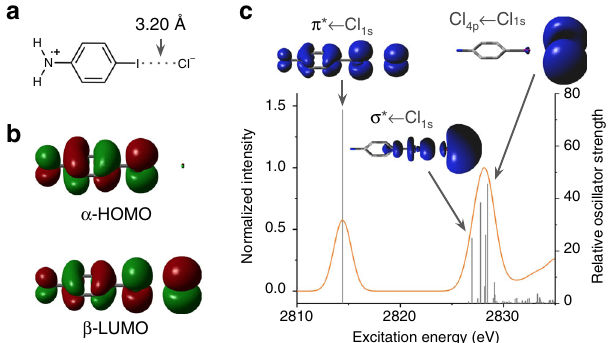
Fig. 5 Simulated [p-iodoaniline] (cid:129) + ···Cl – model system. a The halogen bonding adduct structure of [p-iodoaniline] (cid:129) + ···Cl – . b The α - and β -spin single-electron orbital components of the [p-iodoaniline] (cid:129) + ···Cl – SOMO, the α -HOMO and β -LUMO, calculated at the OOMP2 level and plotted at an isovalue of 0.002. c The con fi guration interaction singles with MP2 doubles correction (CIS(D)) simulated XAS spectrum for [p-iodoaniline] (cid:129) + ···Cl – (calculated using OOMP2, orange line) is shown along with the relative oscillator strengths of the individual calculated transitions (vertical gray lines). The height of the simulated edge peaks was normalized to 1. The transitions corresponding to pre-edge and edge peak features were visualized as EDDMs at an isovalue of 0.0008 (inset). The blue lobes represent positive changes in electron density corresponding to the acceptor orbital(s) of the transitions, while the donor orbital was always the chloride 1s (indicated by a negative change in electron density in red and not always